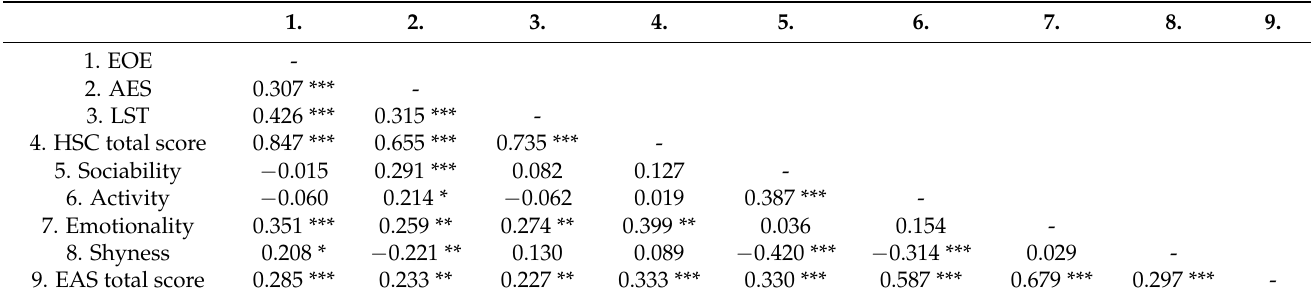
Table 5. Psychometric characteristics of the Spanish version of the HSC scale.